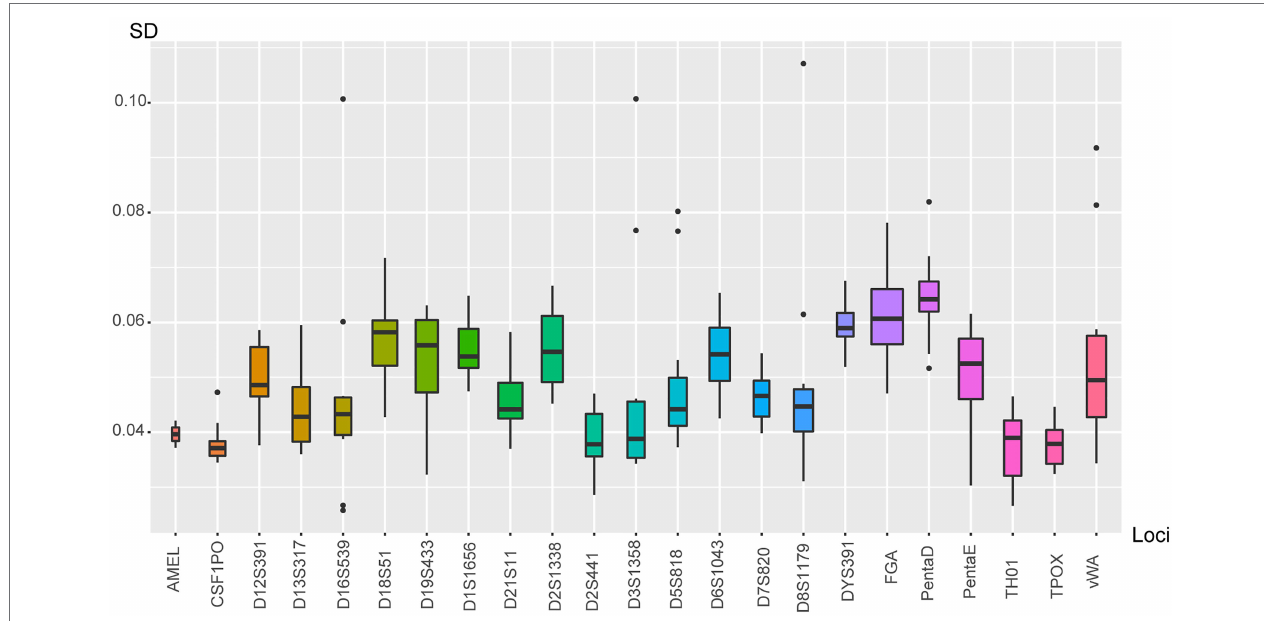
FIGURE 2 | The boxplot showed the SD of allelic ladder sizing. Each box corresponded to a certain locus. Loci were listed at x -axis; SD values were defined as y -axis.